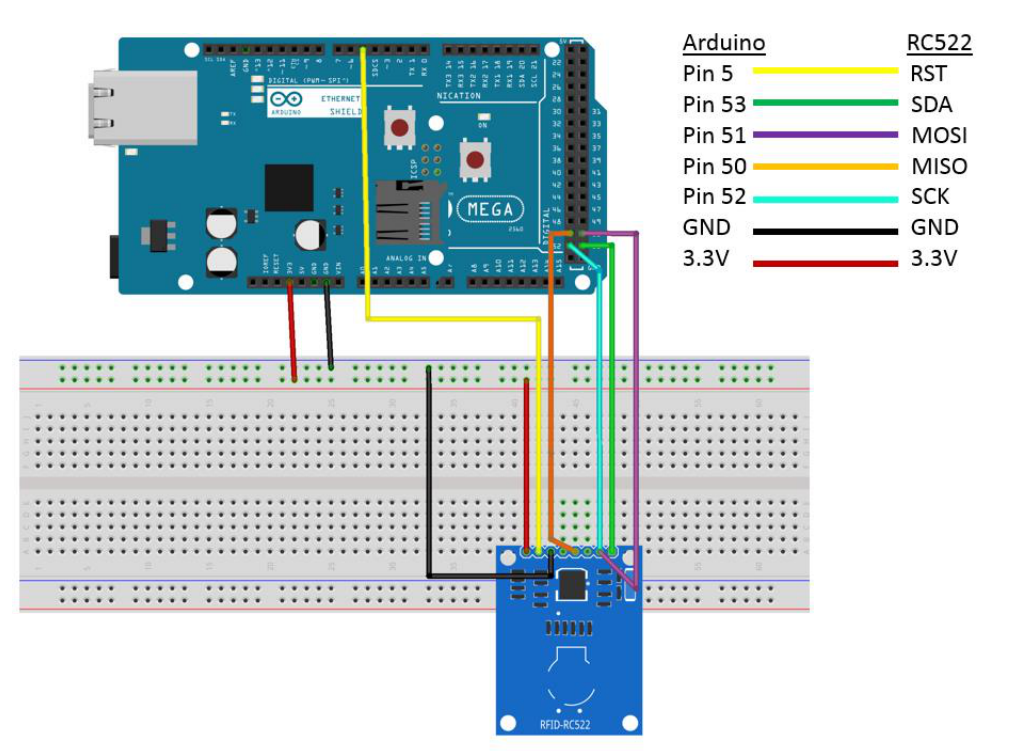
Figure 2. Connection between the RFID module and the Arduino